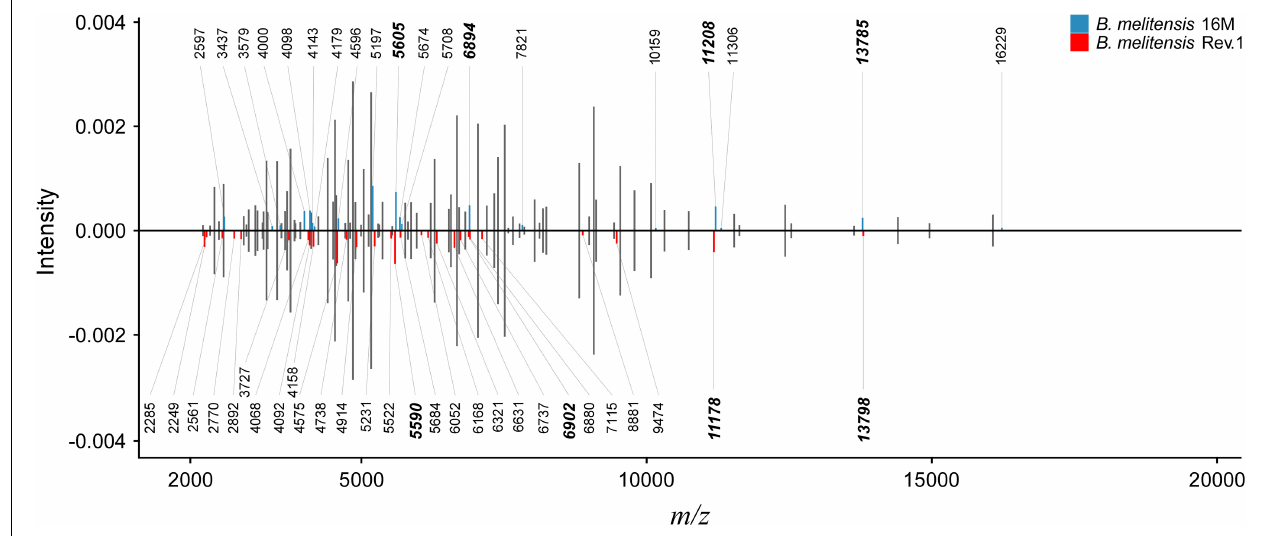
FIGURE 2 | Peak comparison between B. melitensis 16M and B. melitensis Rev.1 strains. Shared peaks with the same m/z values are colored in gray without m/z label. Upper bar plot: B. melitensis 16M with unique peaks colored in blue. Lower bar plot: B. melitensis Rev.1 with unique peaks colored in red. For better comparison, B. melitensis Rev.1 intensity values were multiplied by –1. Bold m/z labels mark peak candidates that match mass difference and absolute mass of short-listed protein variants ( Table 1 ). Peaks were averaged from sample spectra of three biological replicates with a peak frequency threshold of